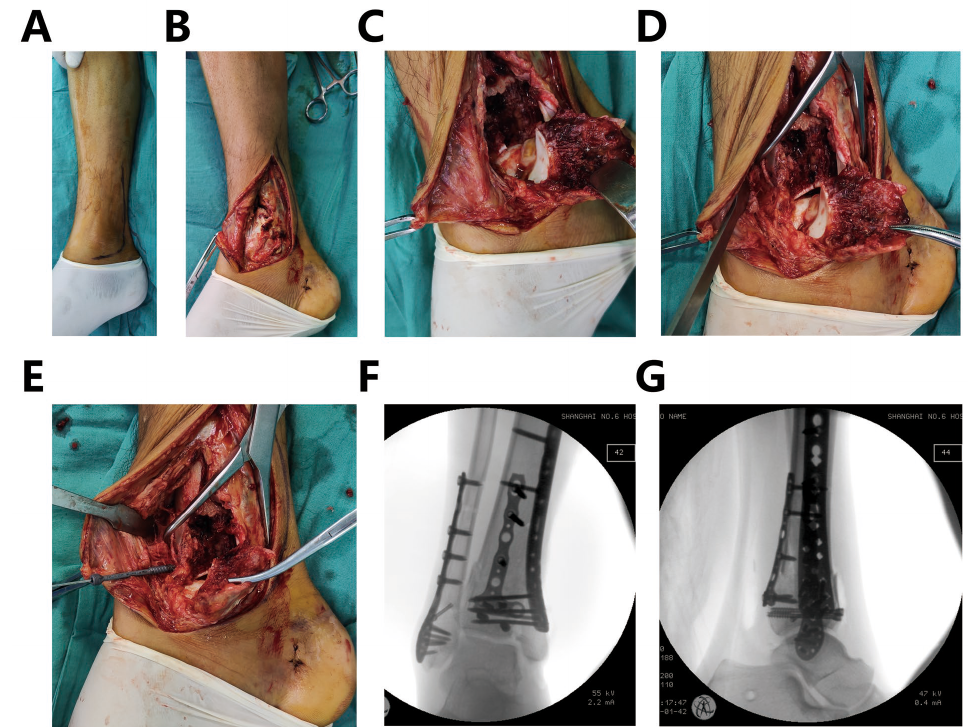
Figure 2. Intraoperative fragments and joint surface reduction procedure and intraoperative fluo- roscopy. ( A ) A medial incision. ( B ) Full-thickness skin flap was lifted over the bone ( C ) The medial fragment was lifted distally along the original fracture line, and the medial and anterior columns were exposed. ( D ) The articular surface was reduced under direct vision and temporarily fixed with point-type reduction forceps. ( E ) Screws were implanted from front to back above the articular surface under direct vision. ( F ) Intraoperative fluoroscopy of anteroposterior view. ( G ) Intraoperative fluoroscopy of lateral view.